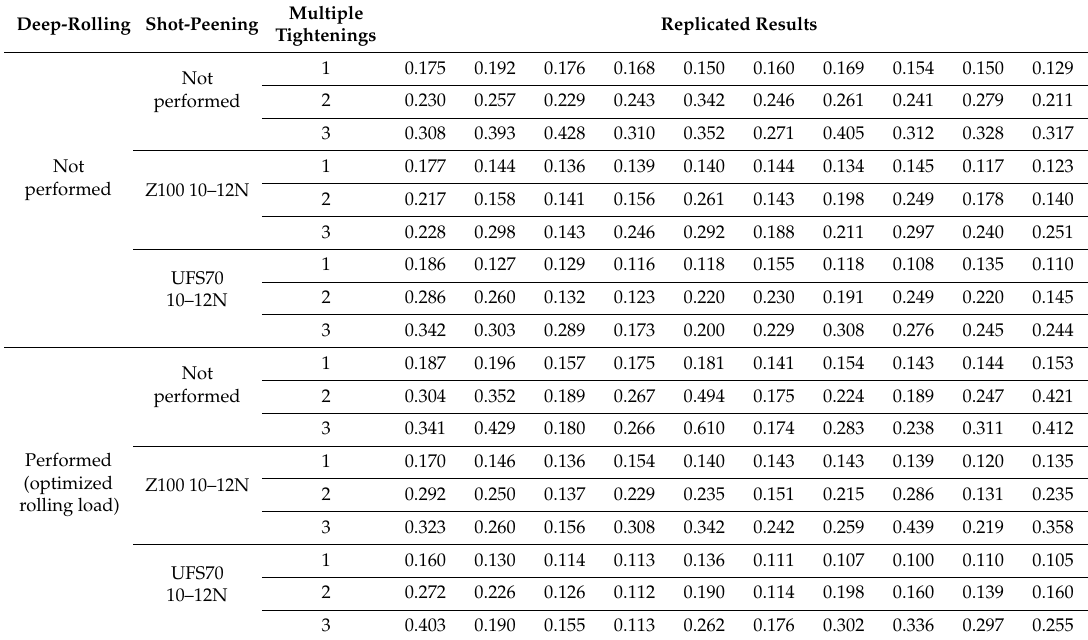
Table 3. Results in terms of bearing friction coe ffi cients ( µ b ) in dry conditions.